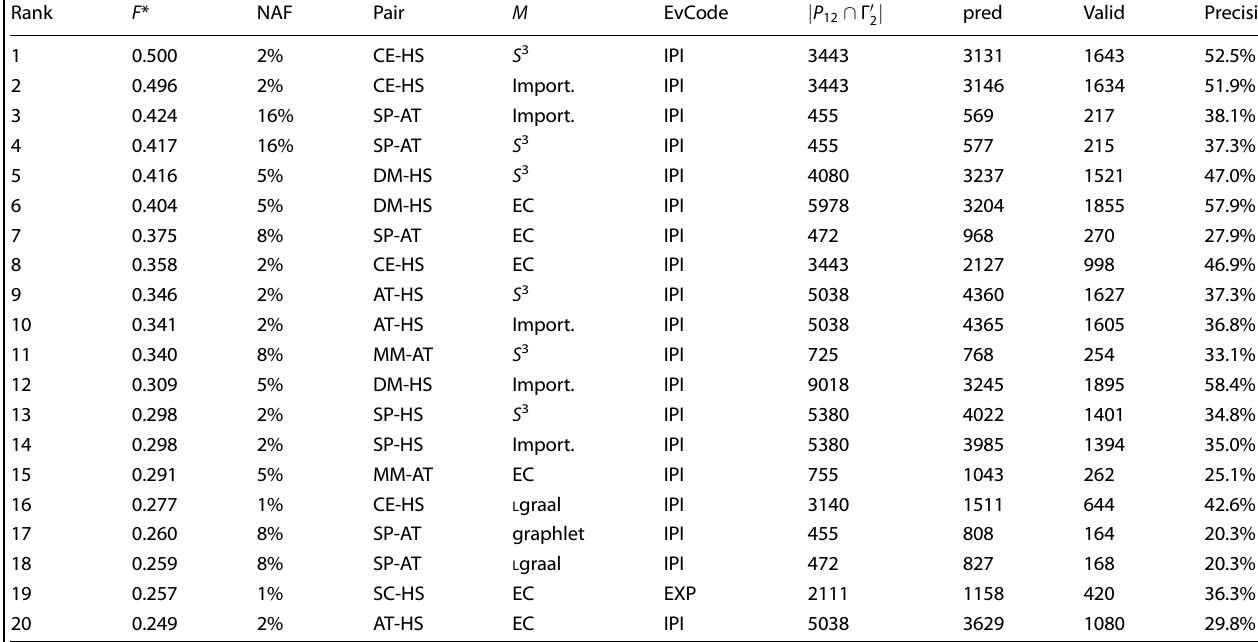
Table 4. 2010-based predictions ranked by F